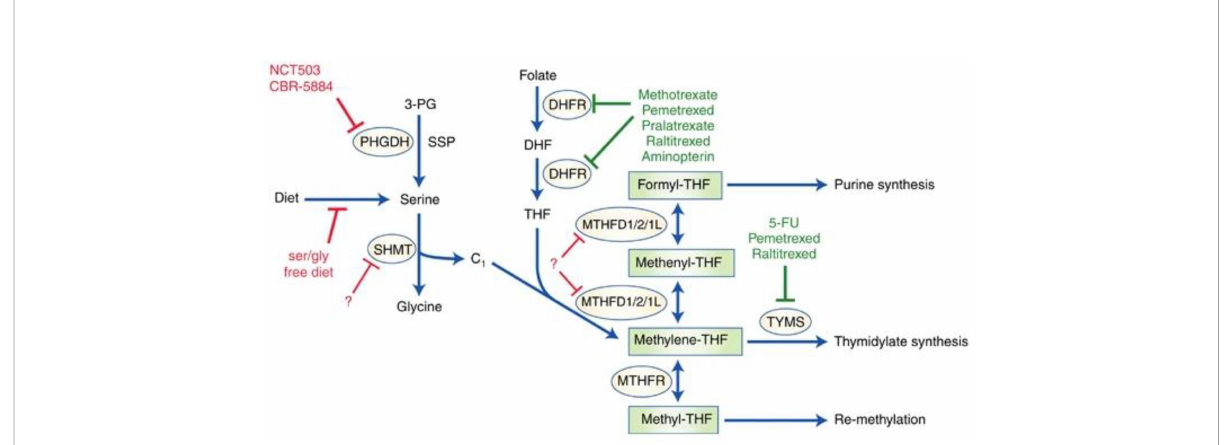
FIGURE 1 One-Carbon Metabolism in Cancer. Note. While one-carbon metabolic pathways characterized by solid chemotherapeutics are highlighted in green, potential future targets are highlighted in red. The solid red line represents interventions under study. Dashed lines represent potential targets that could be investigated. Enzymes regulating these biological pathways are circles. Serine, which can also be synthesized de novo from 3-PG via SSP, a glycolytic intermediate, where PHGDH stands out as the prominent enzyme. Dietary folate is converted to DHF by DHFR and thereafter to THF, which is a recipient of a single carbon. SHMT1/2 catabolizes serine to glycine and subsequently yields a single carbon unit, which THF accepts, hence the formation of methylene-THF. MTHFD1/2/1L can convert the latter to formyl-THF through the intermediate, methenyl-THF. The formyl-THF gives out its single carbon to the purine synthesis cascade. The methylene-THF can either be converted to methyl-THF by MTHFR or give out its single carbon unit to the thymidylate synthesis cascade. The methyl-THF supply carbon units for processes where methionine is